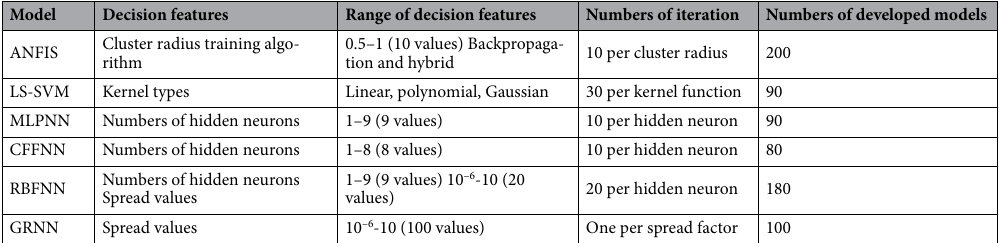
Table 3. General information about the model development phase.